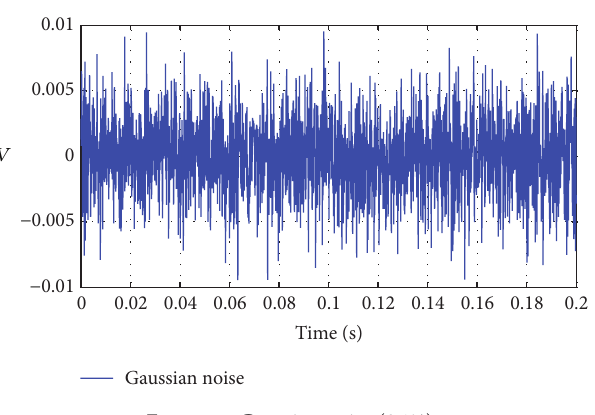
Figure 7: Gaussian noise (0.1%).